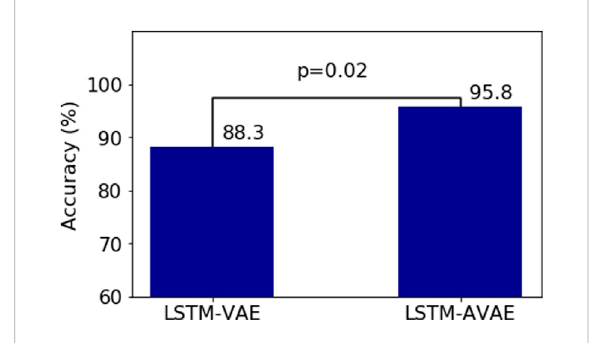
FIGURE 5 Statistical analysis using ANOVA test comparing